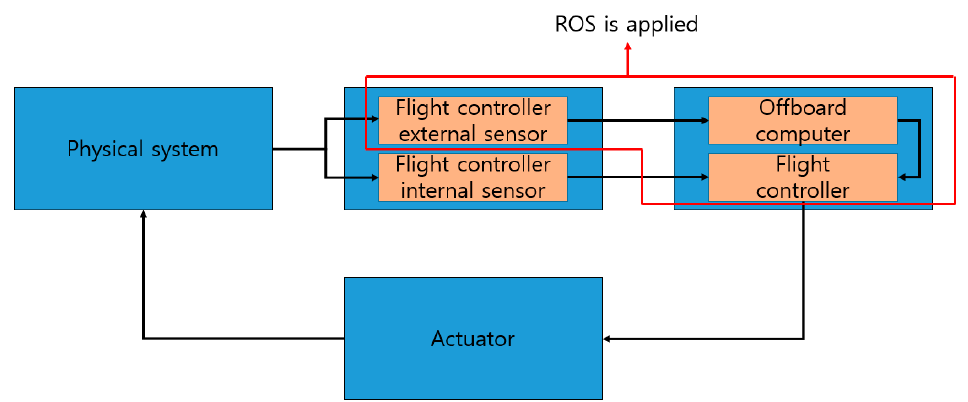
Figure 6. Feedback loop in an unmanned aerial system (UAS). Figure 7, the system model of UAV with ROS through the aforementioned procedure.